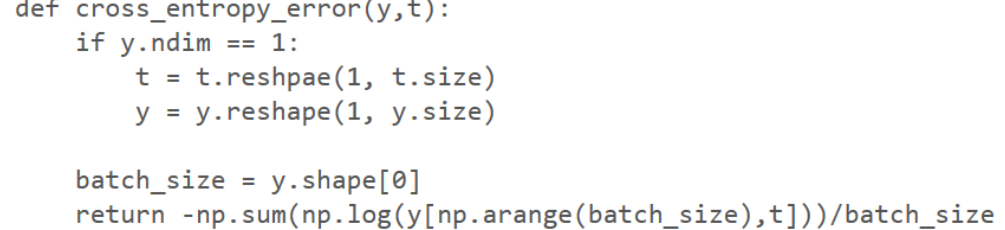
Figure 9. Source result for entropy.